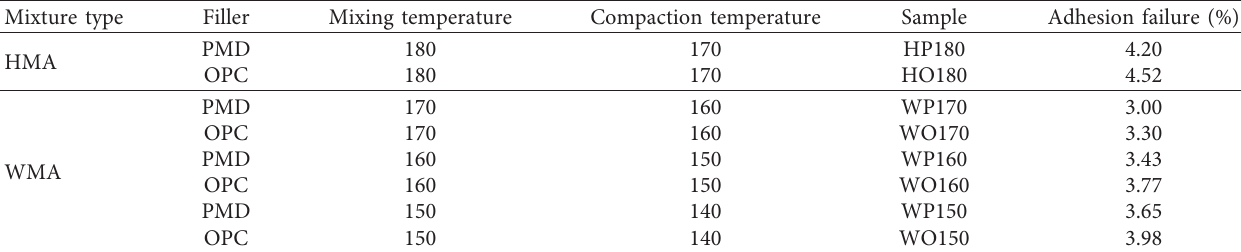
Table 17: Computation for percentage of adhesion failure for 1FT condition.